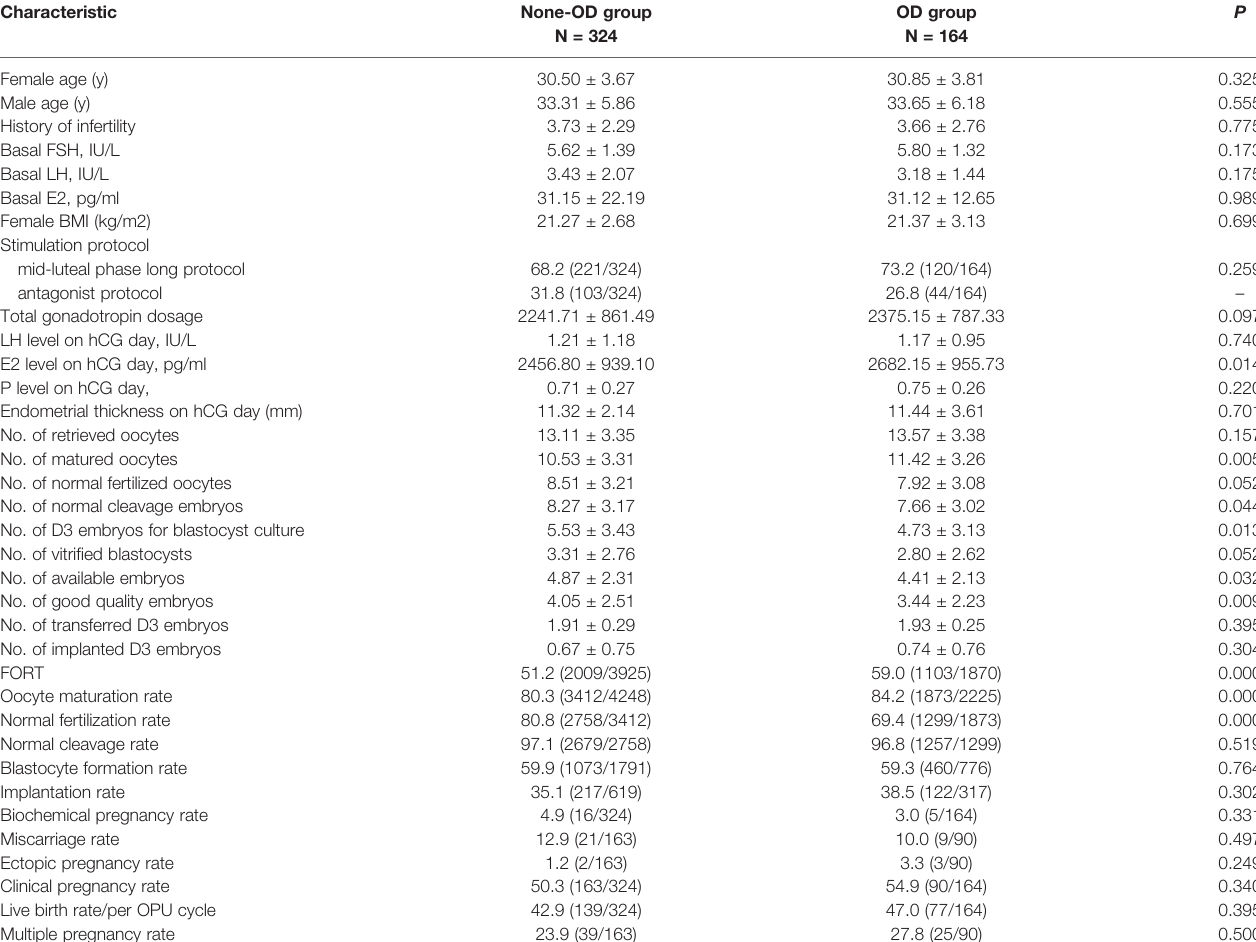
TABLE 1 | Baseline characteristics and reproductive outcomes of fresh cycles between OD group and Non-OD group. Characteristic